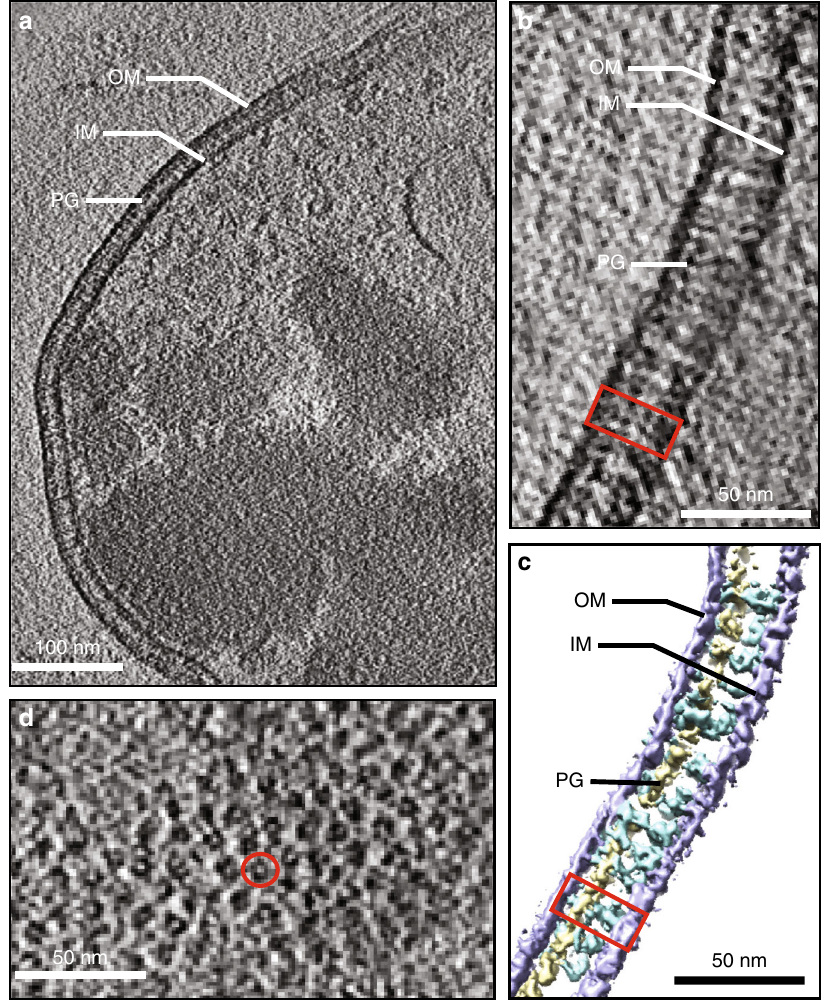
Fig. 1 Visualizing the AcrAB – TolC ef fl ux pump in the E. coli cell envelope. a A single slice from a tomogram of E. coli . The condensed materials shown inside of the cell are inclusion bodies resulting from membrane protein overexpression. b Zoomed inside view of the cell envelope containing the AcrAB – TolC pump which is indicated by the red rectangle. c Corresponding three-dimensional annotation of b showing the outer membrane (OM; blue), the inner membrane (IM; blue), peptidoglycan (PG; yellow), and the AcrAB – TolC pump (cyan). d Top view of the cell envelope containing the AcrAB – TolC pumps which appear as ring-shaped densities (indicated by the red